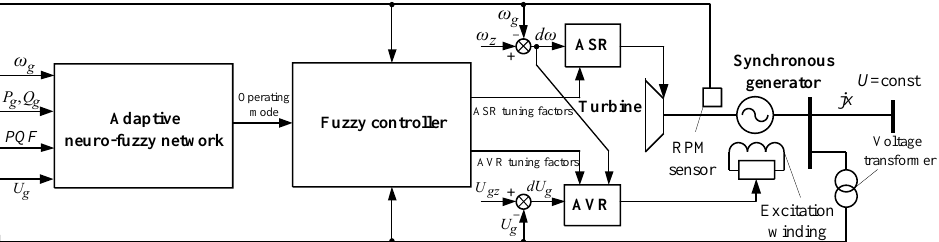
Figure 1. Structural diagram of the DG plant AVR and ASR adaptive control system. ω z , ω g are the preset and current values of the rotor and generator rotational frequency; d ω is the deviation of the rotor rotational frequency from the set value; U gz , U g are the set and current generator voltage value; dU g is the deviation of the generator voltage from the preset value; P g , Q g are active and reactive generator powers.